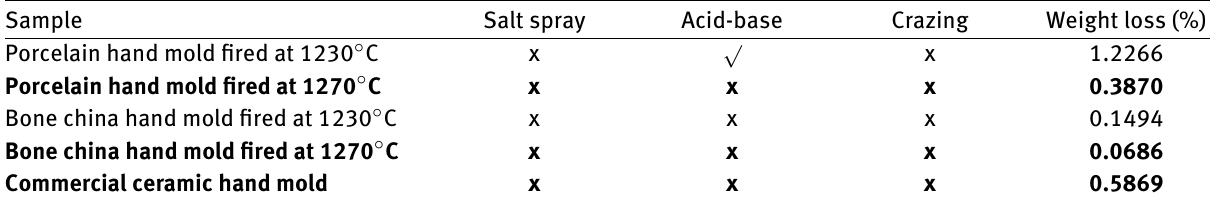
Table 5: Salt spray, acid-base resistance, crazing and the percentage of weight loss of porcelain and bone china ceramic hand molds Sample